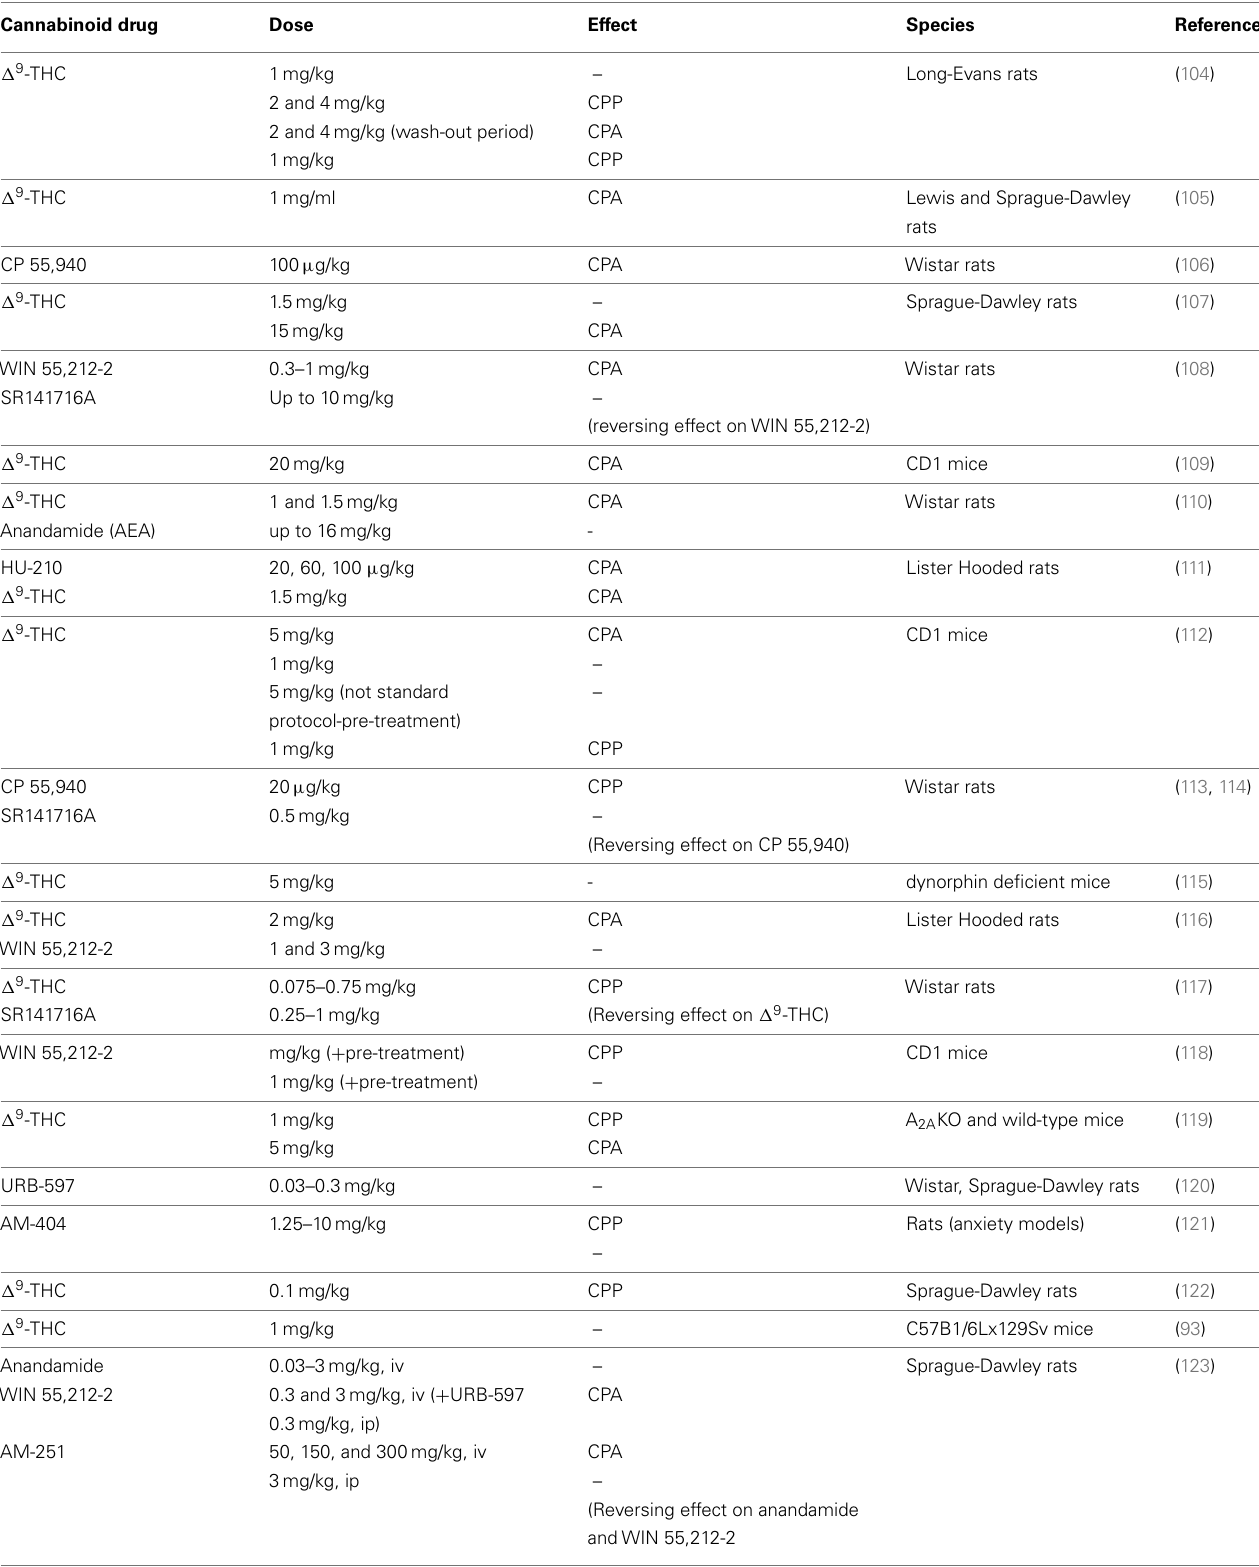
Table 2 | Cannabinoid effects on conditioned place preference in experimental animals . Cannabinoid drug Dose Effect